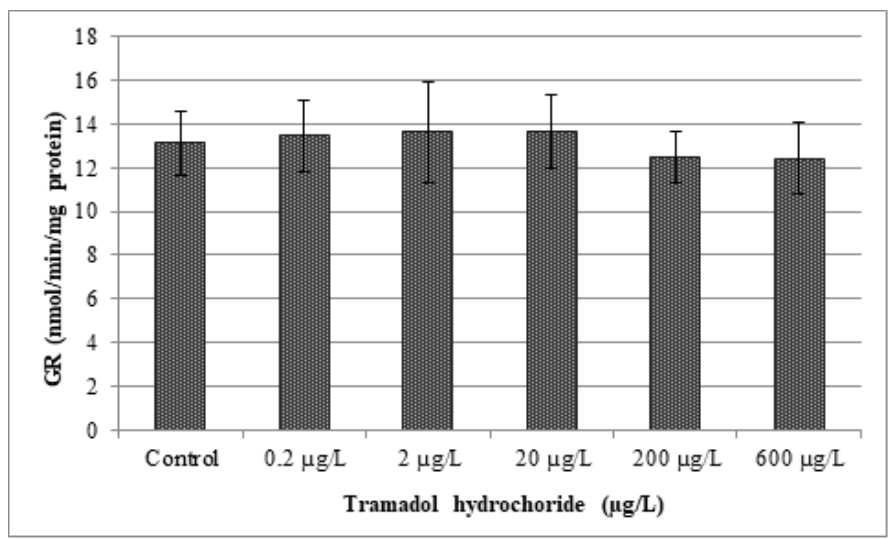
Figure 3. Analysis of glutathione peroxidase activity (GPx) Data are expressed as mean ± standard deviation. No significant differences ( p > 0.05) were found between control and experimental groups.